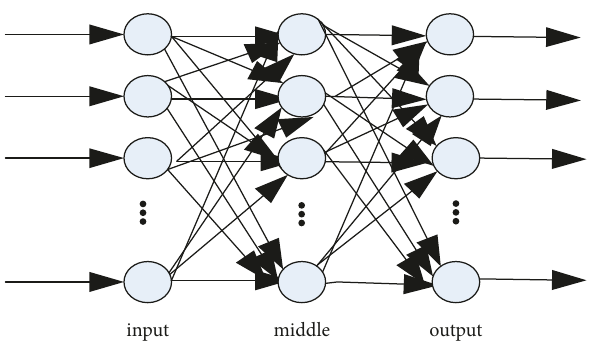
Figure 3: Multilayer feedforward neural